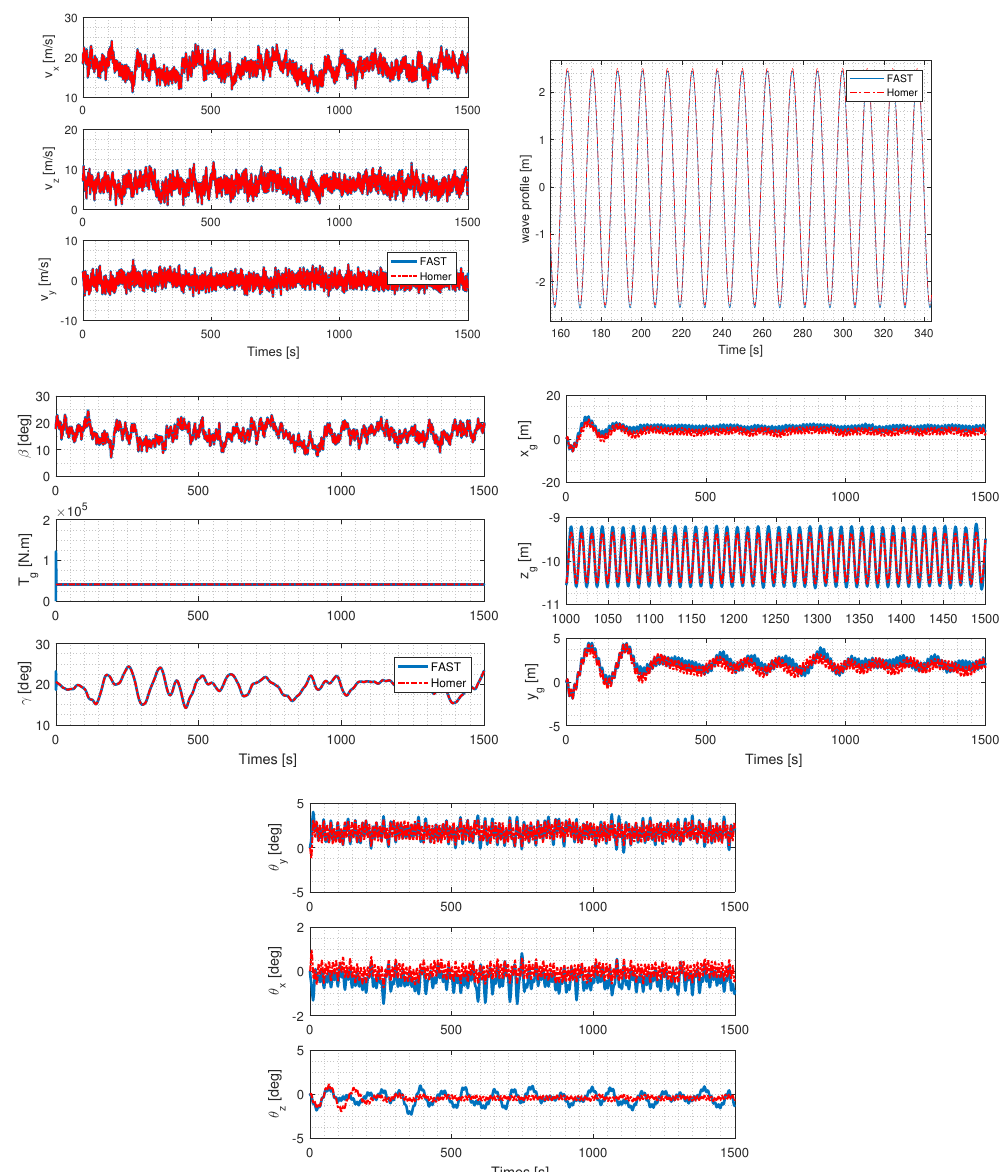
Figure 7. Simulation comparison following conditions of [9] with OpenFAST code in blue and Homer model in red: wind speed profile ( top-left ), generator torque and blade pitch angle control inputs ( top-right ), surge and heave translational DOFs ( bottom-left ) and pitch angular DOF ( bottom-right ).